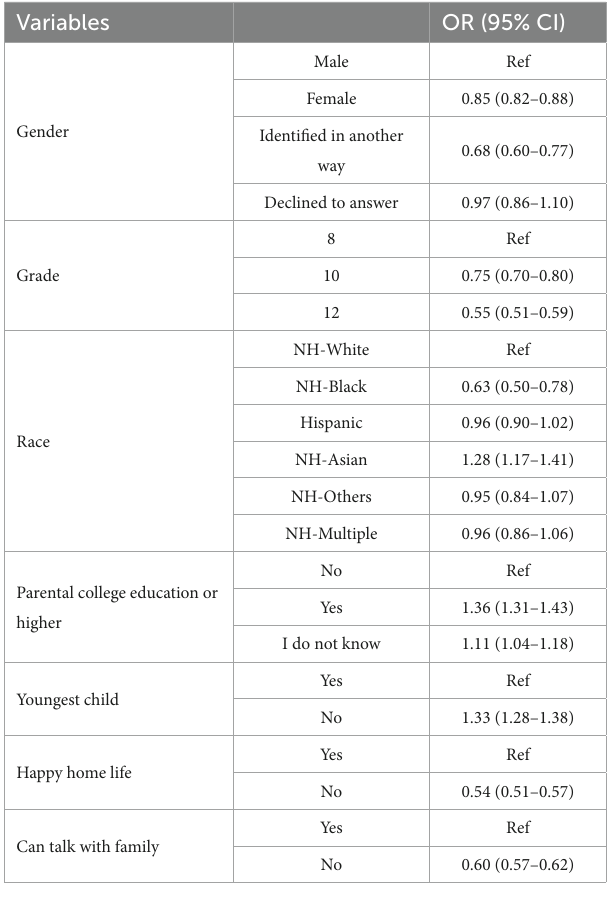
TABLE 3 Association of demographics and family dynamics on frequent family meals, multiple logistic regression modeling ( N = 158,418).